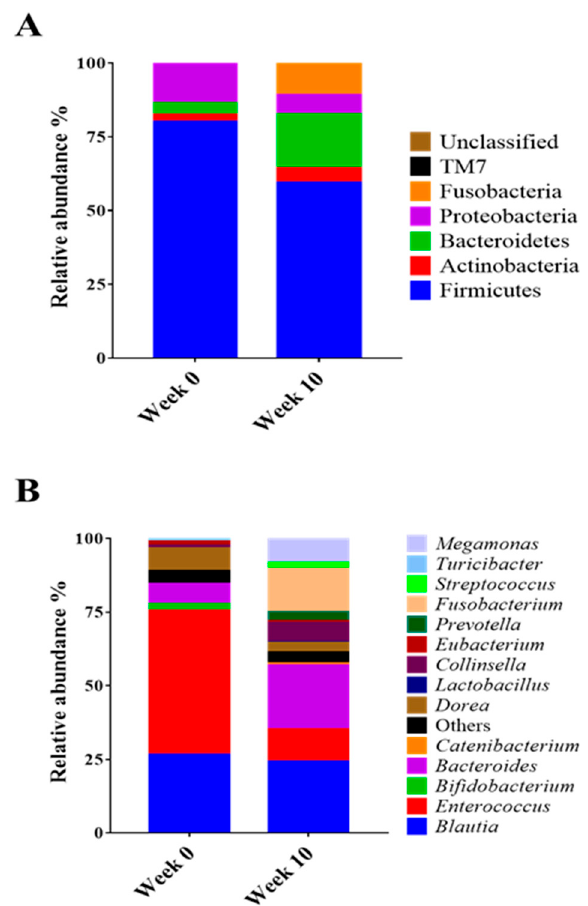
Figure 2. Comparison of taxonomic composition between obese dogs according to synbiotic preparation containing L. gasseri BNR17 supplementation; ( A ): Phylum, ( B ): Genus.